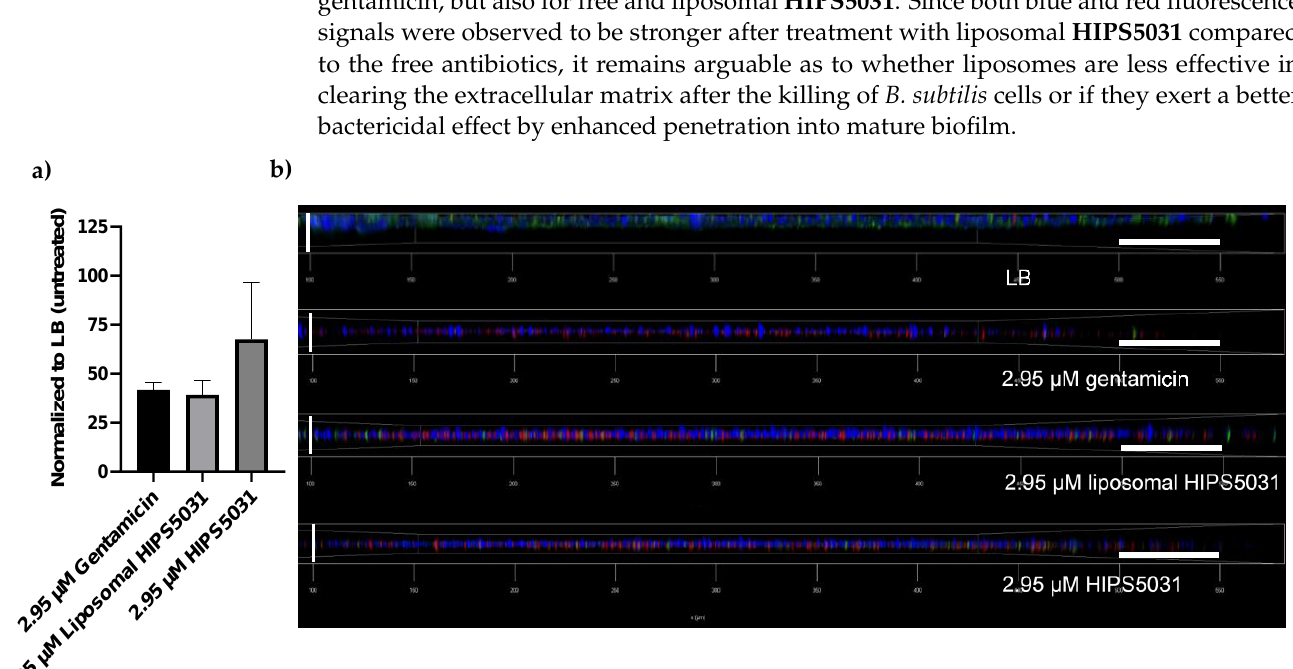
Figure 8. B. subtilis 168 biofilm for fluorescence analysis and imaging: ( a ) mean fluorescence intensity of viable bacteria cells within the preformed biofilm stained with SYTO9 after treatment with 2.95 µM of either gentamicin, HIPS5031 , or liposomal HIPS5031 , as measured with a microplate reader and normalized to the untreated control (LB) ( n = 3); ( b ) confocal laser scanning micrographs of preformed biofilms treated with 2.95 µM of either gentamicin, HIPS5031 , or liposomal HIPS5031 , and compared to the control (LB). Biofilms were stained with Hoechst 33342, propidium iodide and SYTO9, leading to blue, green, and red fluorescence of extracellular DNA, cells, and damaged cells, respectively. Horizontal scale bars = 50 µm, vertical scale bars = 18 µm.